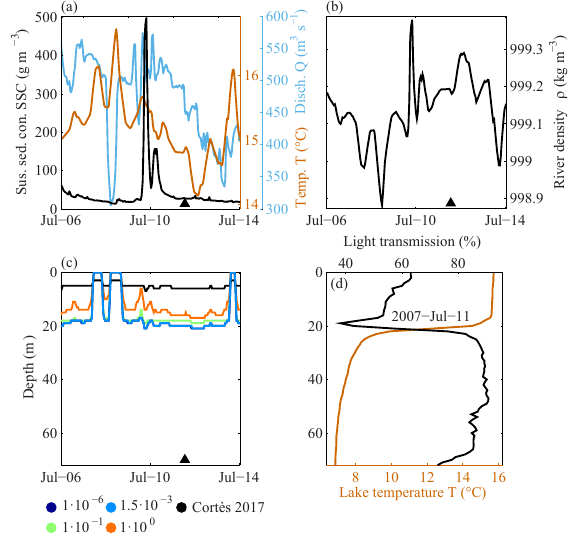
Figure A2. River intrusion entrainment sensitivity analysis for the LB/Aare system in July 2007. (a) SSC (black), temperature ( T ; or- ange) and river discharge ( Q ; blue) from Aare station no. 2085. (b) River density at station no. 2085 obtained from T and SSC in (a) . (c) River intrusion depth calculated from Appendix A with varying entrainment constant β (Eq. A13); light green denotes the value used in this study; black indicate intrusion depth modeled as in Cortés et al. (2014). (d) Vertical measurements of T and light transmission in LB for 11 July 2007. The triangles in (a) – (c) mark the time of the vertical profile in (d)